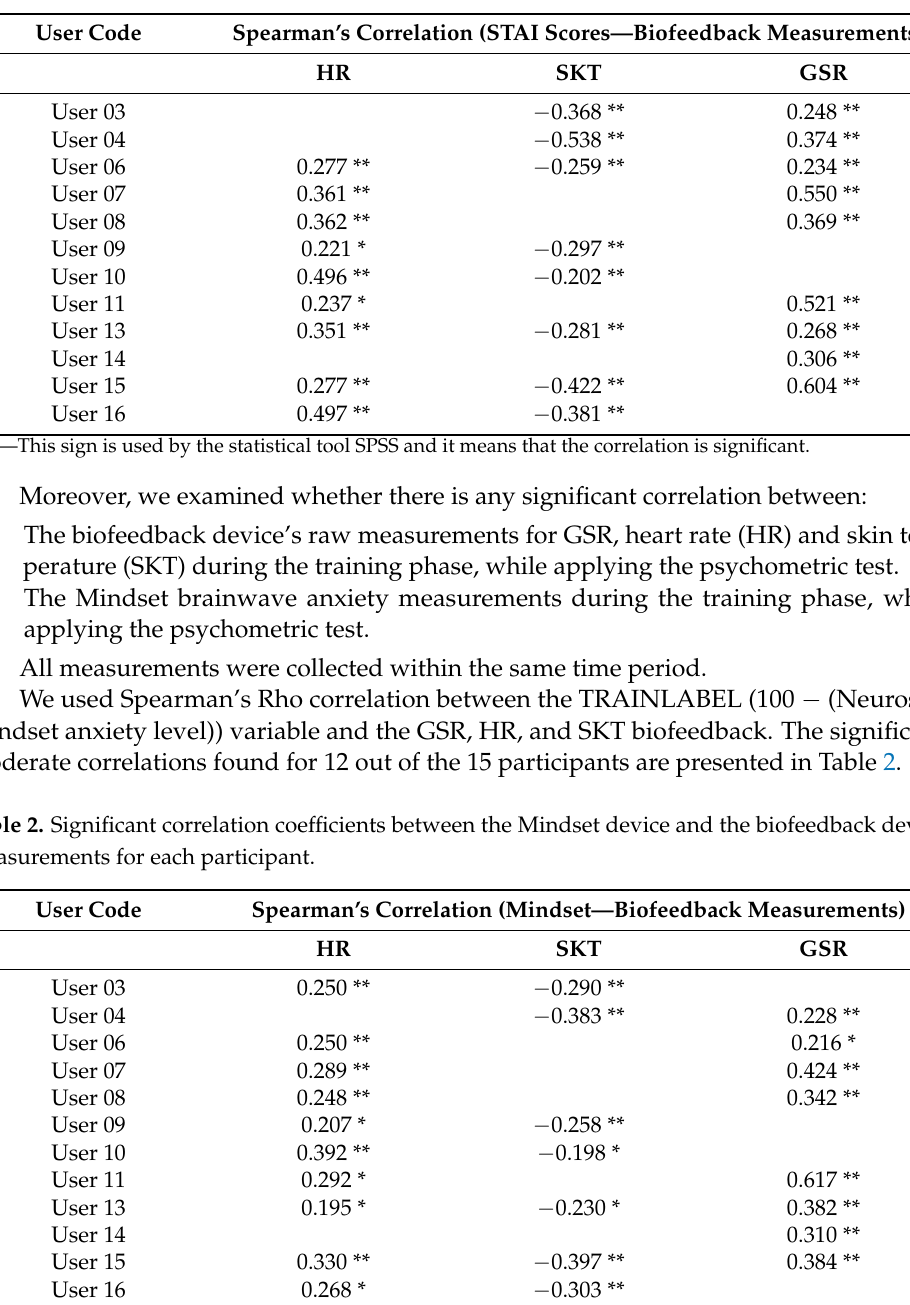
Table 1. Significant correlation coefficients between the State-Trait Anxiety Inventory (STAI) scores and biofeedback device measurements for each participant.